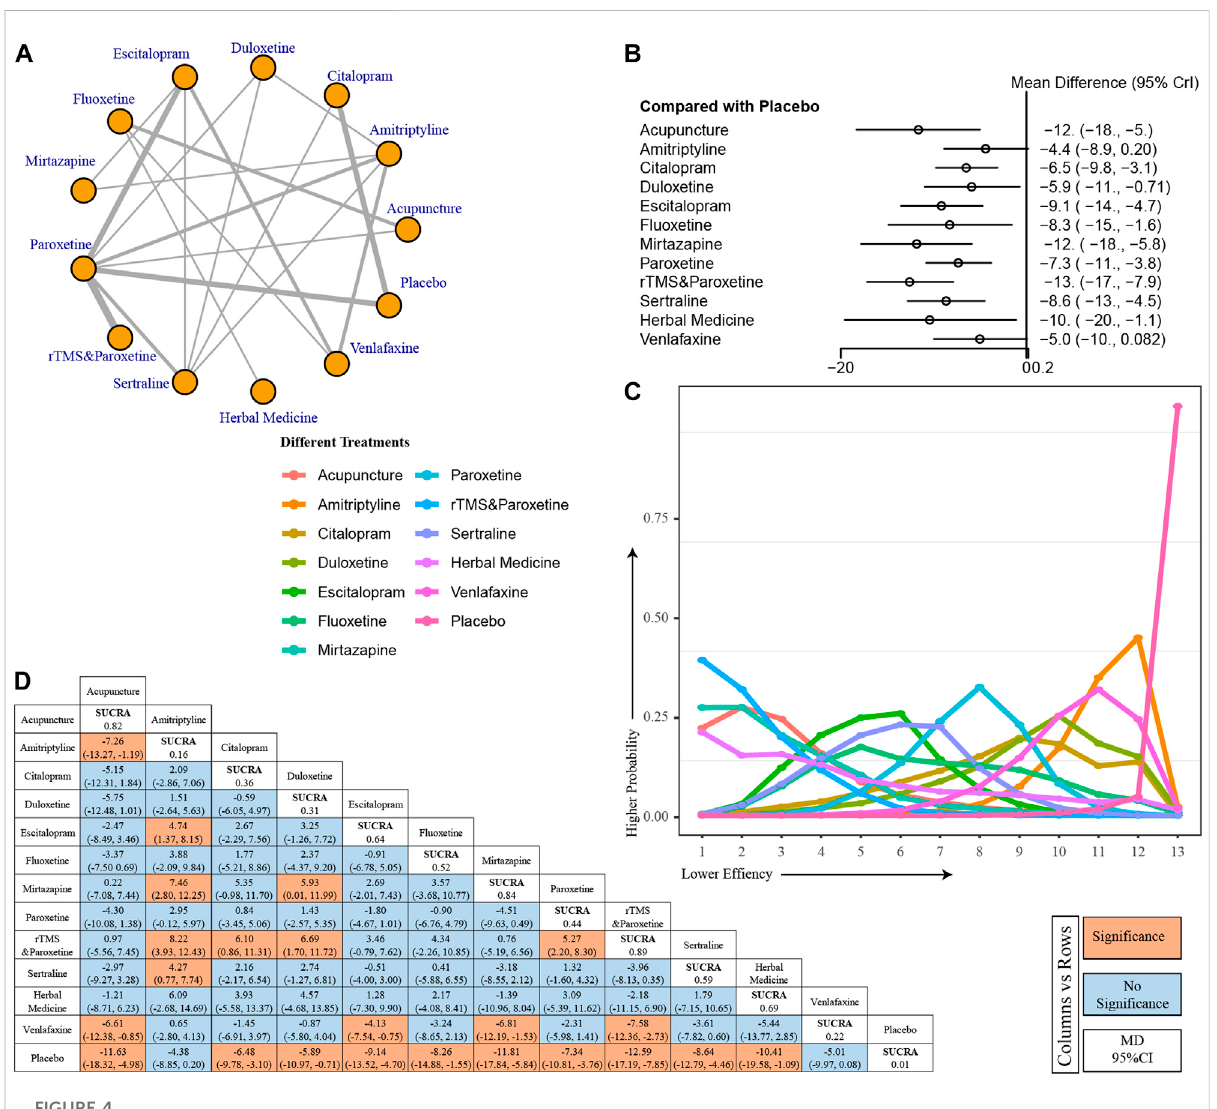
I HAMD change at end of 8th week. (A) Network model. (B) Forest plot for comparisons between treatments and placebo. (C) Line graph for probability ranks. (D) League